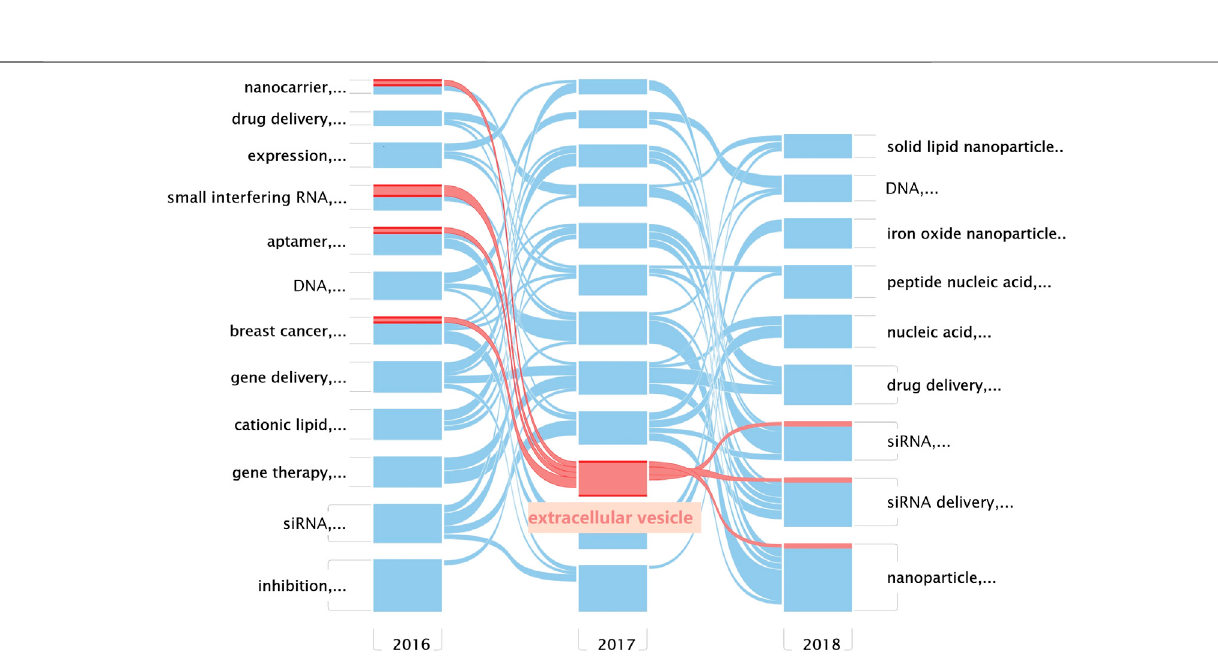
FIGURE 5 | Details of the cluster extracellular vesicle and its